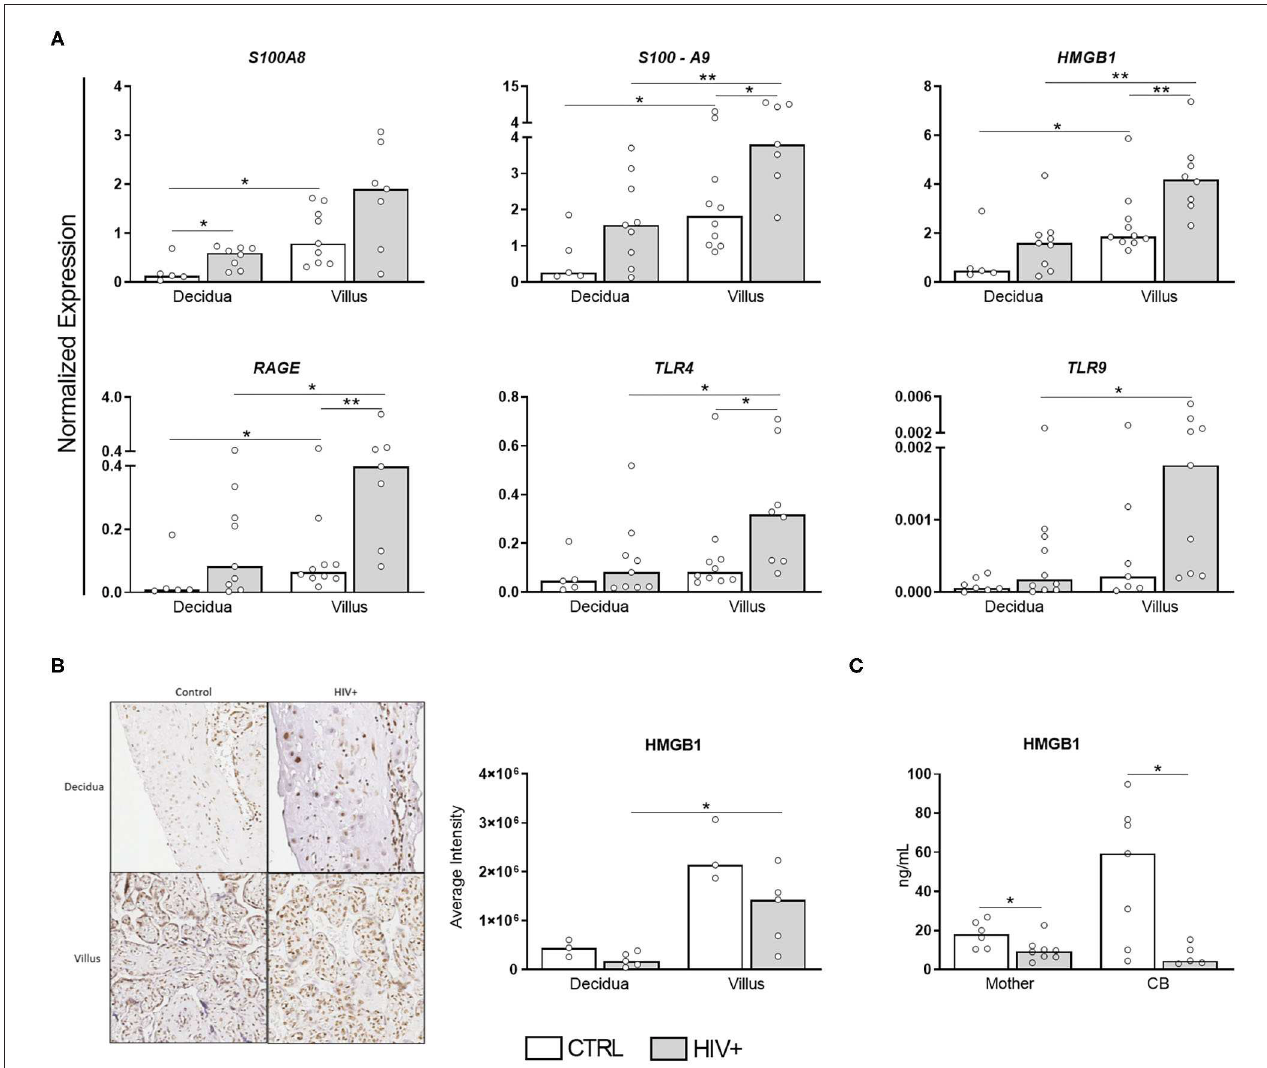
FIGURE 1 | DAMPs are up-regulated in placental chorionic villi but HMGB1 serum levels are decreased in HIV-infected mothers and CB. (A) mRNA expression levels of S100A8, S100A9, HMGB1, RAGE, TLR4, and TLR9 in decidua and chorionic villi from HIV-infected (gray bar, n = 7–10) and uninfected mothers (white bar, n = 5–10) was evaluated by RT qPCR. (B) HMGB1 expression was analyzed by immunohistochemistry in decidua and villi from HIV-infected (gray bar, n = 5) and uninfected mothers (white bar, n = 3). (C) HMGB1 levels in serum from HIV-infected (gray bar, n = 5–8) and uninfected mothers/newborns pair (white bar, n = 6–7) evaluated by ELISA. The detection limit for HMGB1 was 2.5ng/mL. Data represent median values. Mann-Whitney U or Wilcoxon signed-rank test: * p < 0.05, ** p <